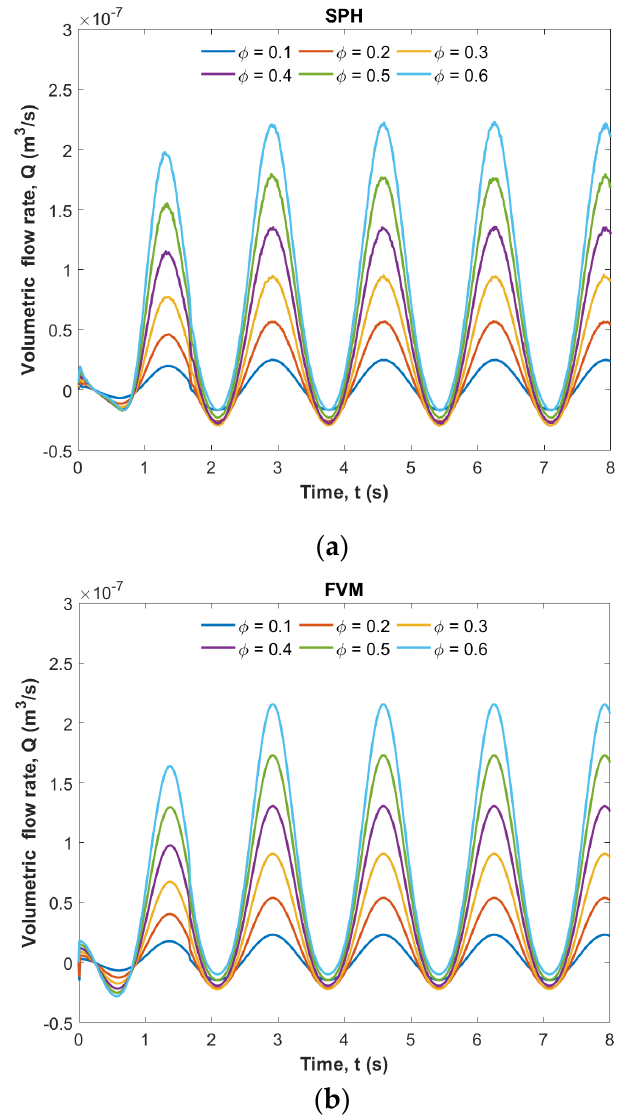
Figure 8. Volumetric flow rate at the mid cross-section over time: ( a ) SPH, ( b ) FVM.